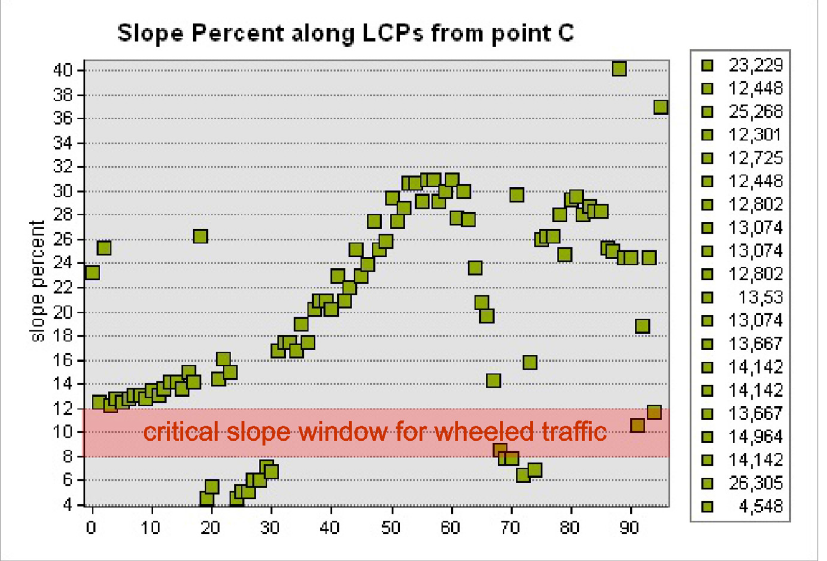
Figure 13. Correlation of percent slopes with the LCPs based on an 8% critical slope raster originating from point C towards all